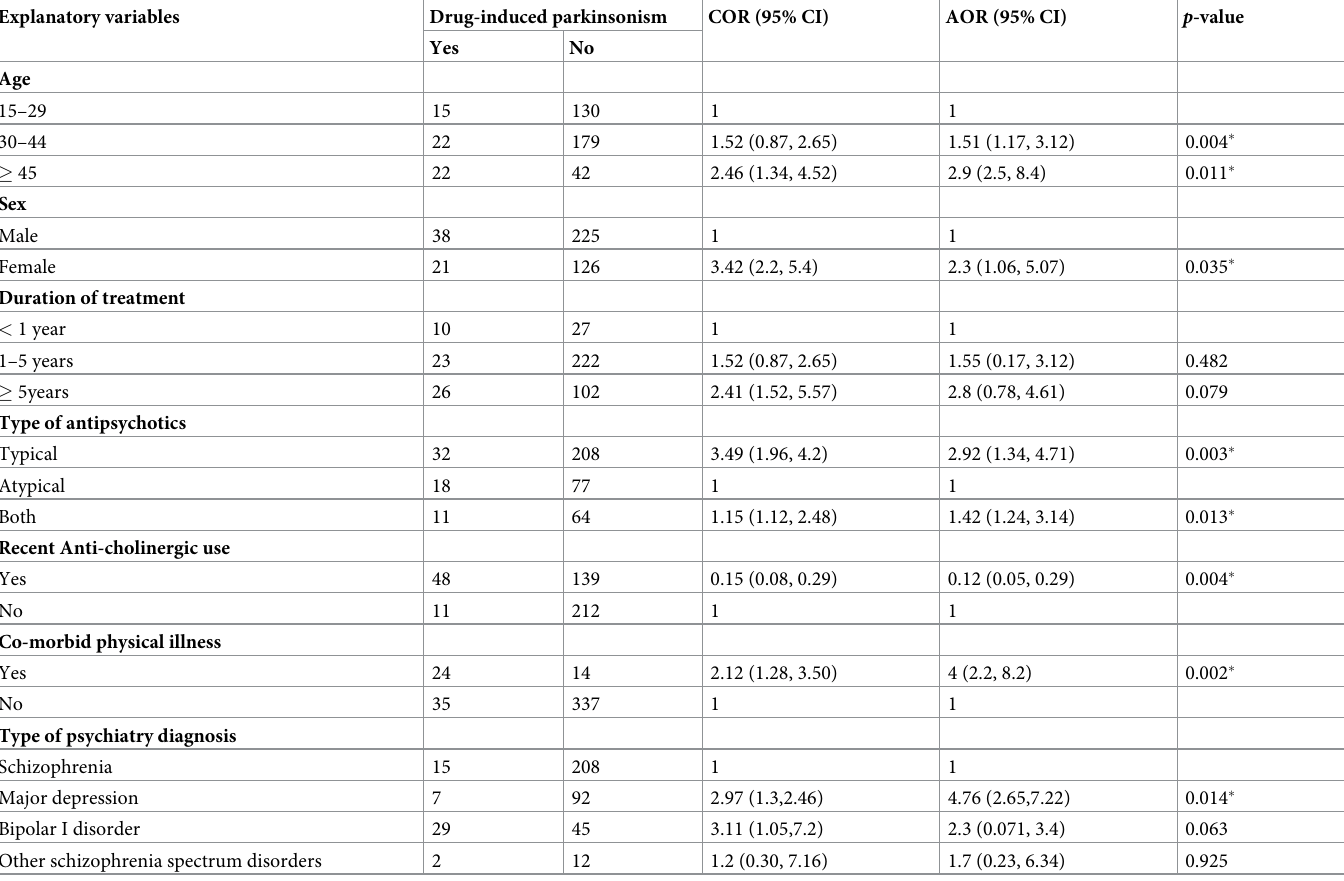
Table 3. Factors associated with drug-induced parkinsonism among patients taking antipsychotics and attending follow-up treatment at JMC,